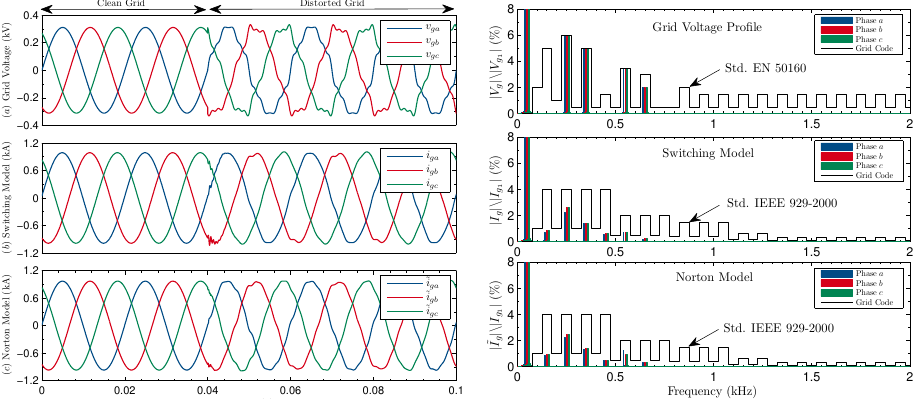
Figure 15. Output current of whole converter by using switching and Norton models under rated power and distorted grid, time ( left ), and harmonic ( right ) responses: ( a ) grid voltage and its harmonic response; ( b ) switching model and its harmonic response; ( c ) Norton model and its harmonic